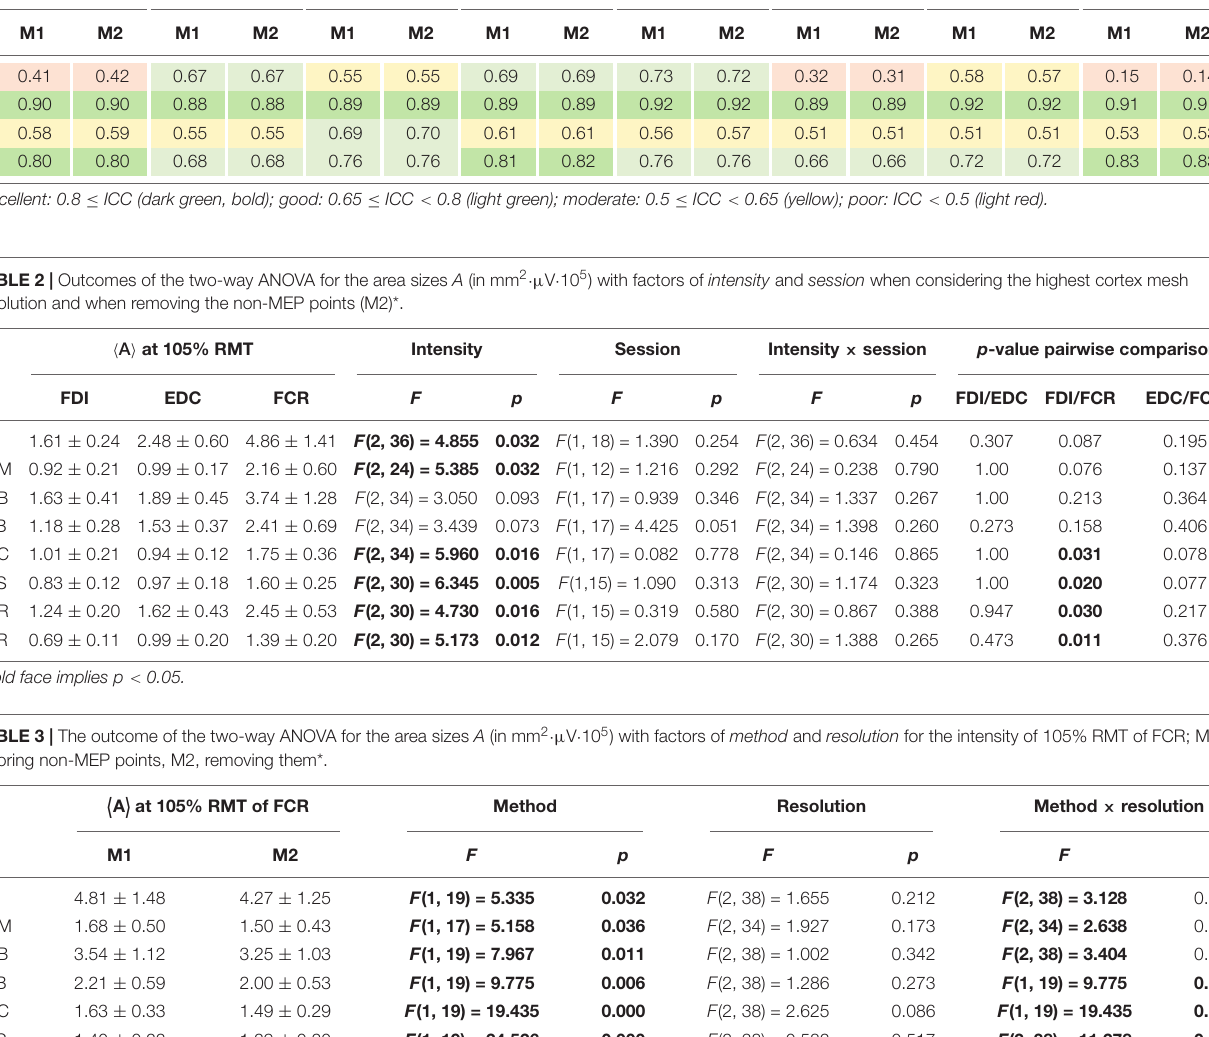
TABLE 1 | ICC values of area sizes A and centroids C = (cid:0) C x , C y , C z (cid:1) T estimated for intensity of 105% RMT of FCR using the cortical meshes with maximum resolution when ignoring non-MEP points (M1) or removing them (M2)*. FDI ADM APB FPB EDC FDS